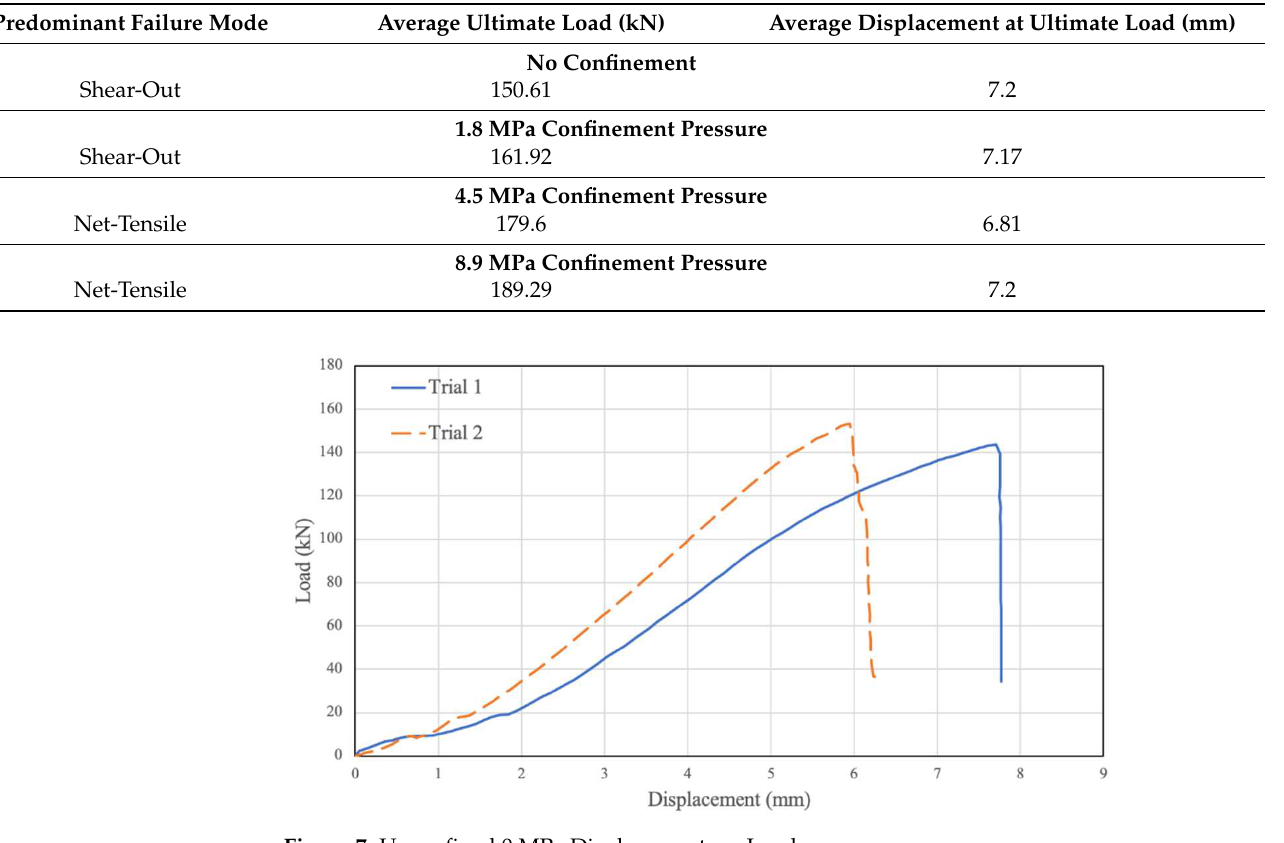
Table 2. Summary of Test Results.